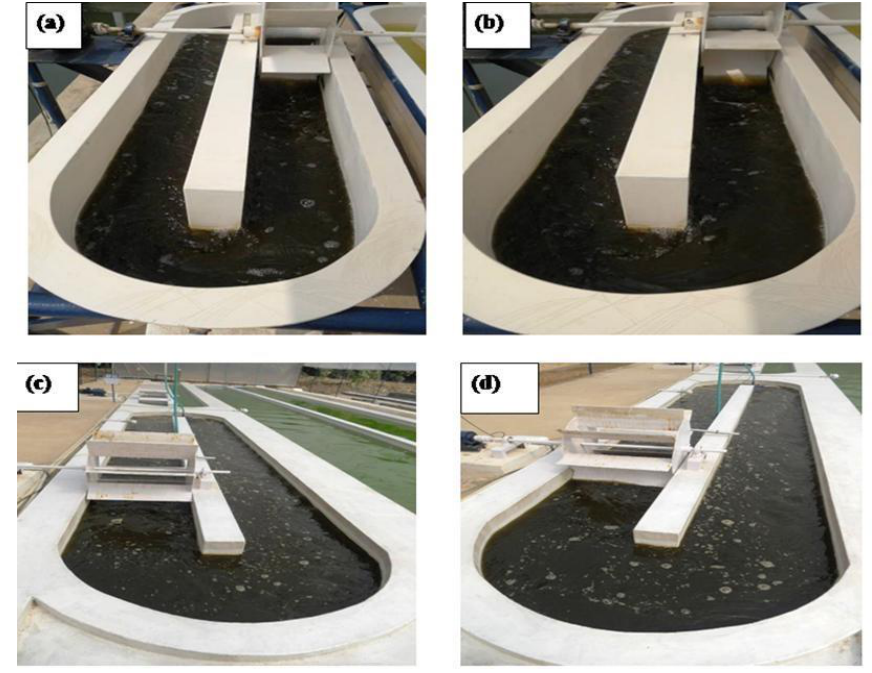
Figure 3. ( a ) Growth for F/2 medium. ( b ) Modified CFTRI-RRACI medium. ( c , d ) Different days of growth for modified CFTRI-RRAC-I medium in outdoor cultivation.